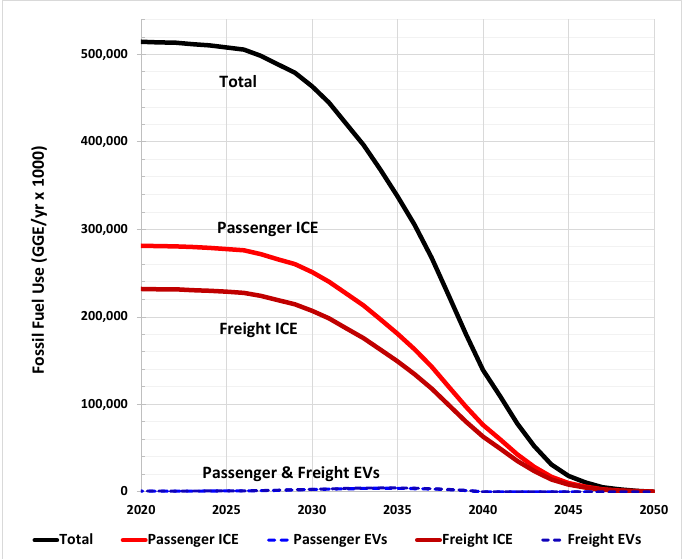
Figure 13. With the most ambitious scenario in this analysis, Scenario #1, total fossil fuel use for passenger ICE vehicles powered by gasoline, and freight ICE vehicles powered by gasoline and diesel, contrasted with passenger and freight EVs powered on Oahu as EVs replace ICE vehicles and renewables replace fossil fuels for power generation.